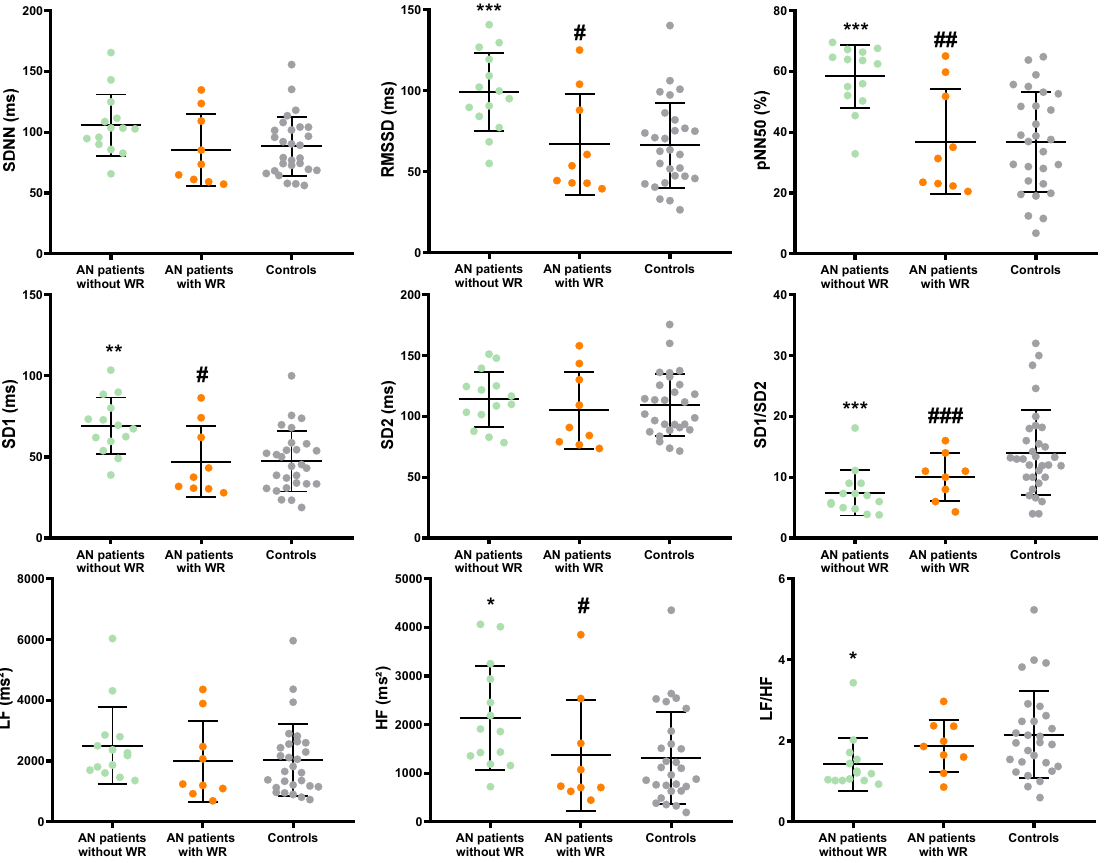
Figure 3. Heart rate variability parameters of AN patients (with, in orange and without WR, in green) and controls (in grey). Significantly different from Controls (*: p < 0.05; **: p < 0.01; ***: p < 0.001); Significantly different from AN patients with WR ( # : p <0.05; ## : p <0.01; ### : p < 0.001)